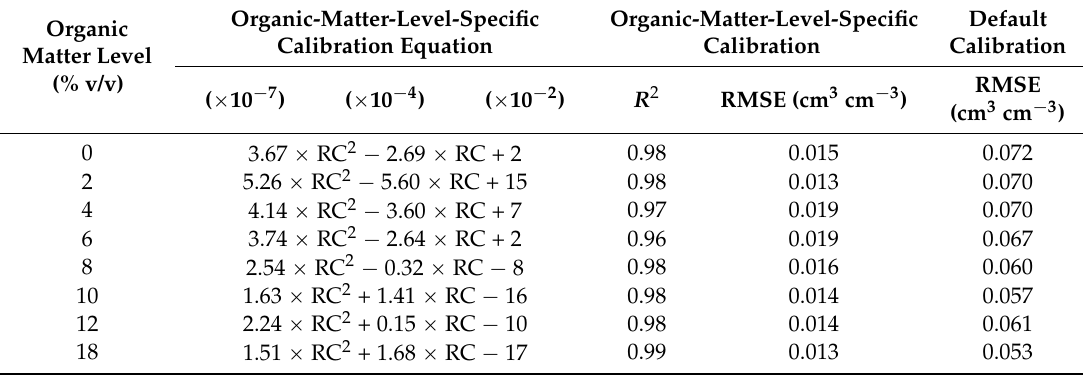
Figure 5. Comparison of apparent water content predicted using the default (red circles) and the new multivariate polynomial calibration (blue circles) equations with actual water content (solid line) as a function of organic matter level. Table 2 . Summary of organic-matter-level–specific calibration equations ( n = 72).